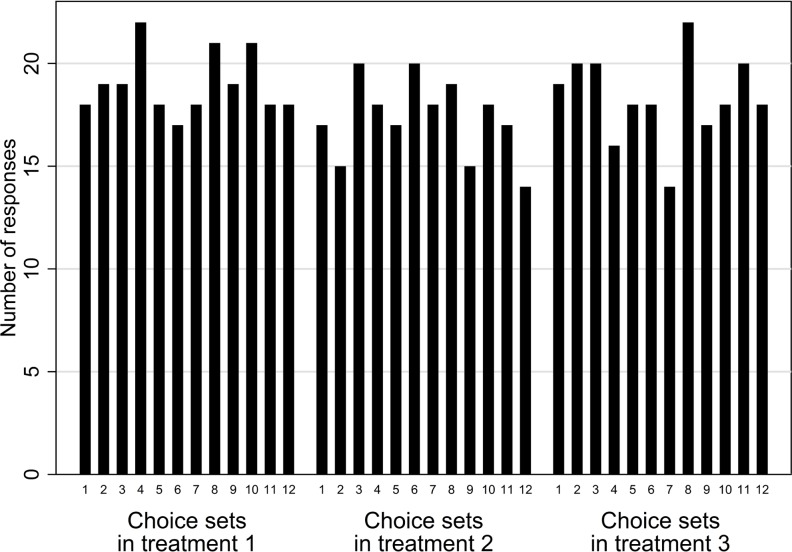
Responses per choice scenario.